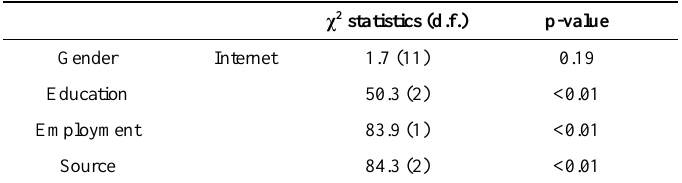
Table 3. Chi-square test for independence (association) between the Internet use and the given